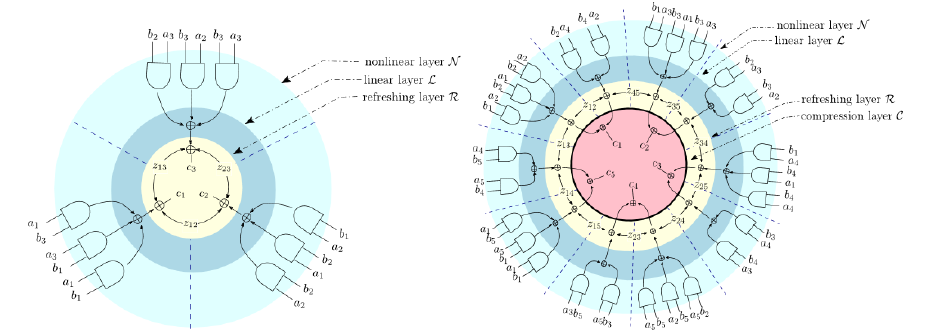
Figure 9: First- and second-order threshold implementation with randomness [RBN +